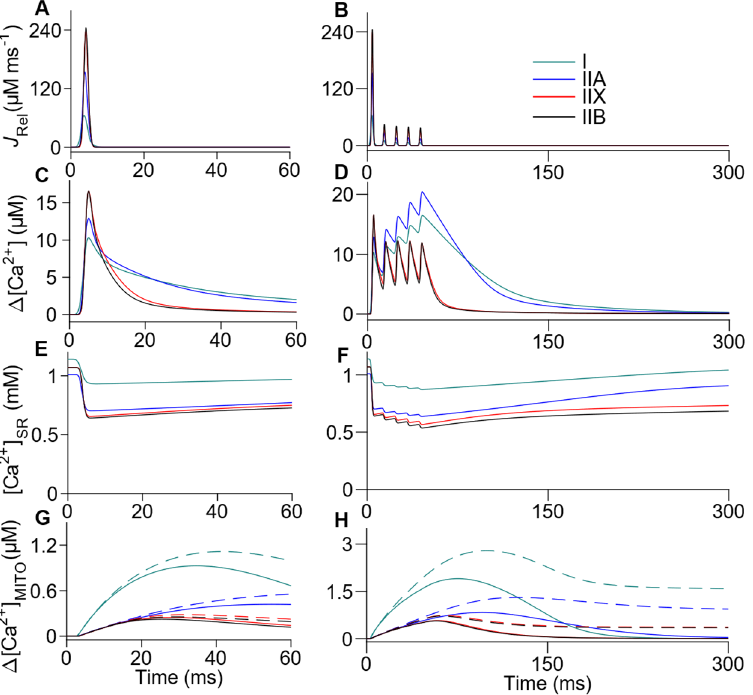
Figure 2. Simulation of release rate of Ca 2+ and free [Ca 2+ ] in the three compartments of the model. The release rate of Ca 2+ was estimated from the measurements of ∆ [Ca 2+ ] in fibers I, IIA, IIX, and IIB ( A ). The model was used to reproduce the Δ [Ca 2+ ] obtained experimentally in the sarcoplasm ( C , D ) and to estimate the Δ [Ca 2+ ] in the SR ( E , F ), and MITO ( G , H , solid line). The release rate of Ca 2+ was used in the first AP of the tetanic Ca 2+ transient simulation and in subsequent AP rescaled to match the experimental Δ [Ca 2+ ] peaks ( B ). The tetanic Ca 2+ transient of IIA and IIX fibers were simulated assuming that they share morphology with I and IIB fibers, respectively. The total [Ca 2+ ] in MITO during the Ca 2+ transients ( G , H , dashed lines), was obtained from the sum of Δ [Ca 2+ ] MITO and the Ca 2+ bound to B. MITO simulations were extended in time for the tetanic transients in the Figure S1, in order to show the return of [Ca 2+ ] to the basal levels.